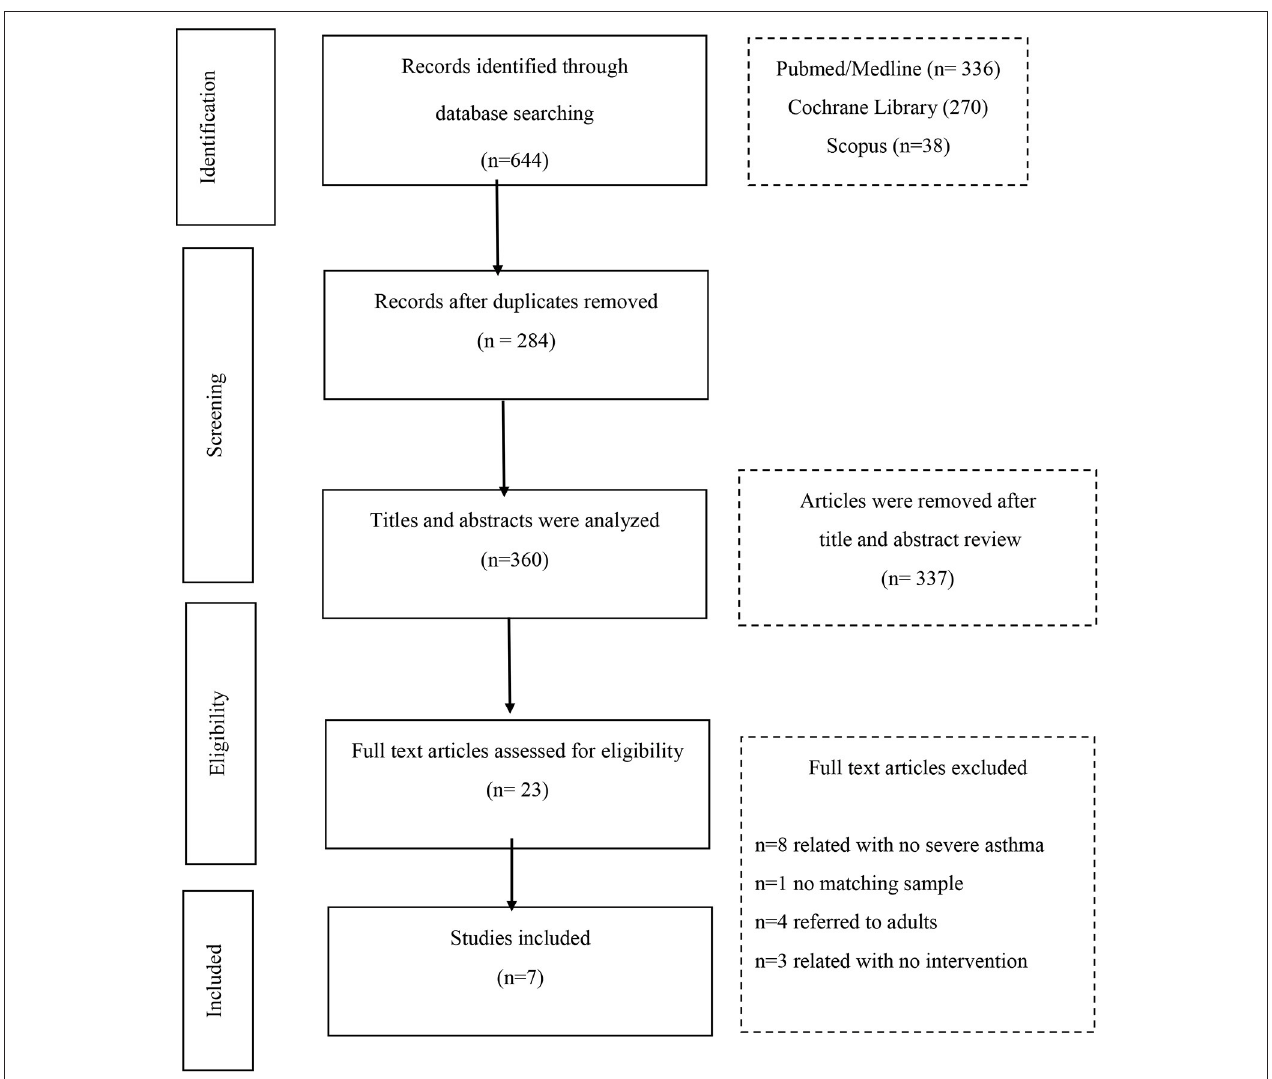
FIGURE 1 | Flow diagram of studies included in systematic